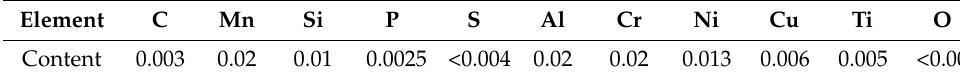
Figure 2. Sampling process. Table 1. Chemical compositions of industrial pure iron (weight percent).